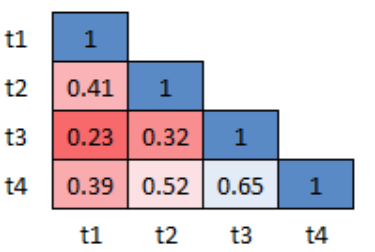
Fig. 9 Inter-sessions test-retest validation for version 1: Heatmap showing the average p -values for the 4 sessions across participants